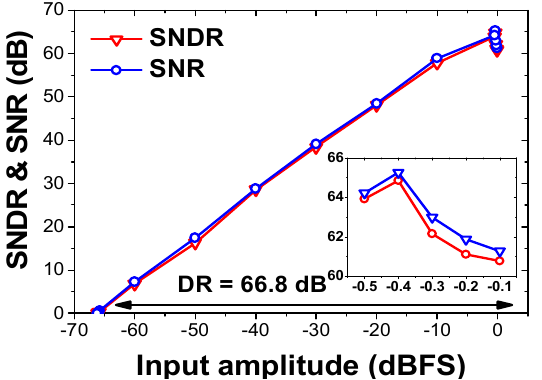
Figure 15. Measured dynamic range.